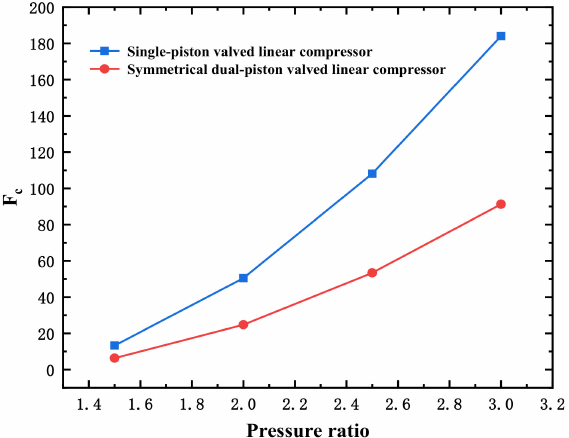
Figure 7. Variances of the two types of linear compressors under different pressure ratios.